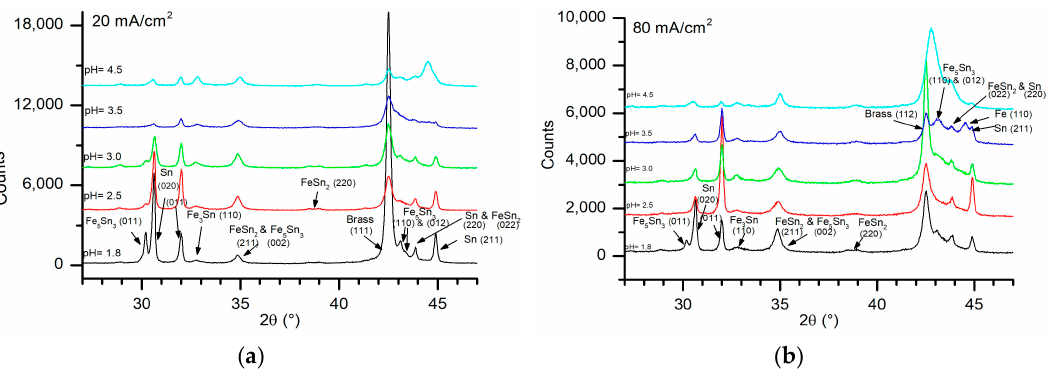
Figure 6. The most relevant part of the XRD diffraction pattern (2 θ : 27°–47°) for the phase identification. Samples were deposited from the Fe(III)–Sn(II) electrolytes (both Fe and Sn 0.11 M) at different pH values with the current density of: ( a ) 20 mA/cm 2 , ( b ) 80 mA/cm 2 .